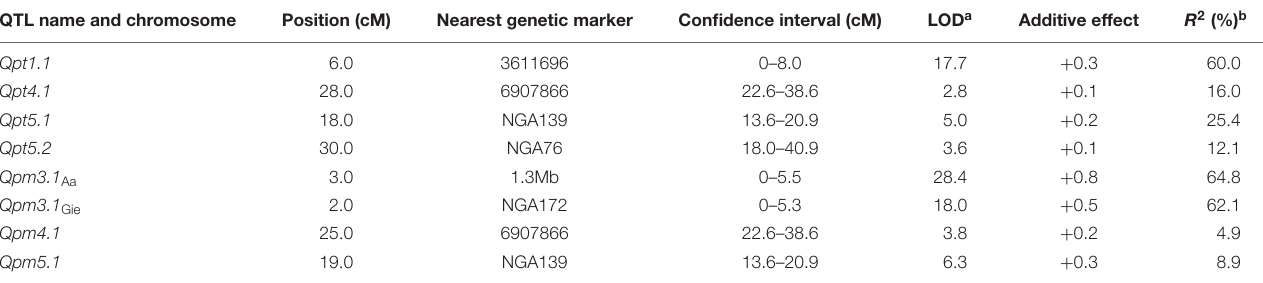
FIGURE 3 | Arabidopsis quantitative trait loci (QTLs) controlling variation in disease resistance to P. syringae infection. (A,B) QTLs underlying the resistance variance to DC3000-lux in Col × Aa (A) and Col × Gie (B) RILs. (C,D) QTLs underlying the resistance variance to ES4326-lux in Col × Aa (C) and Col × Gie (D) RILs. QTL analyses are based on genotypic data and levels of bacterial luminescence of the RILs. The curved lines indicate likelihood statistics (scores of the likelihood of odds, LOD) for the positions of QTLs and the significance threshold at 95% confidence interval calculated by permutation tests ( n = 1000) is plotted as horizontal lines. I–V denote five individual linkage groups. Positions of the markers used for analysis are indicated as small dots. Peaks of LOD scores are indicated by filled triangles along with the values. TABLE 1 | Summary of Arabidopsis quantitative trait locus (QTL) conferring resistance to lux tagged Pseudomonas syringae pv. tomato DC3000 ( Qpt ) and pv. maculicola ES4326 ( Qpm